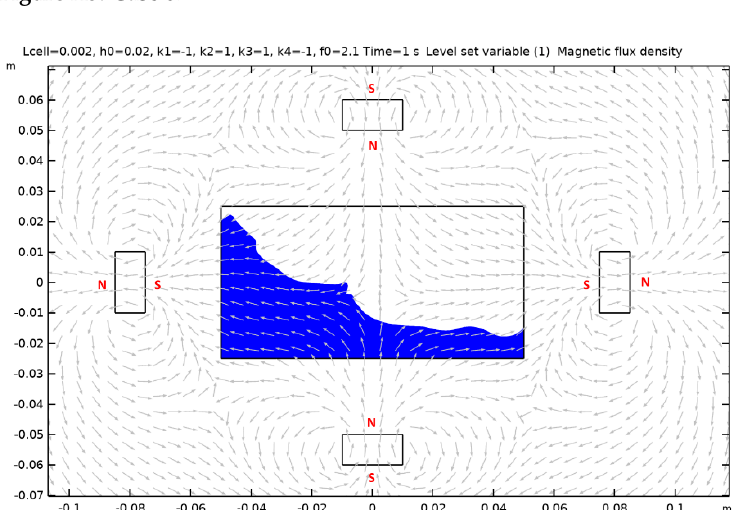
Figure A5. Case 6. Figure A5. Case 6.